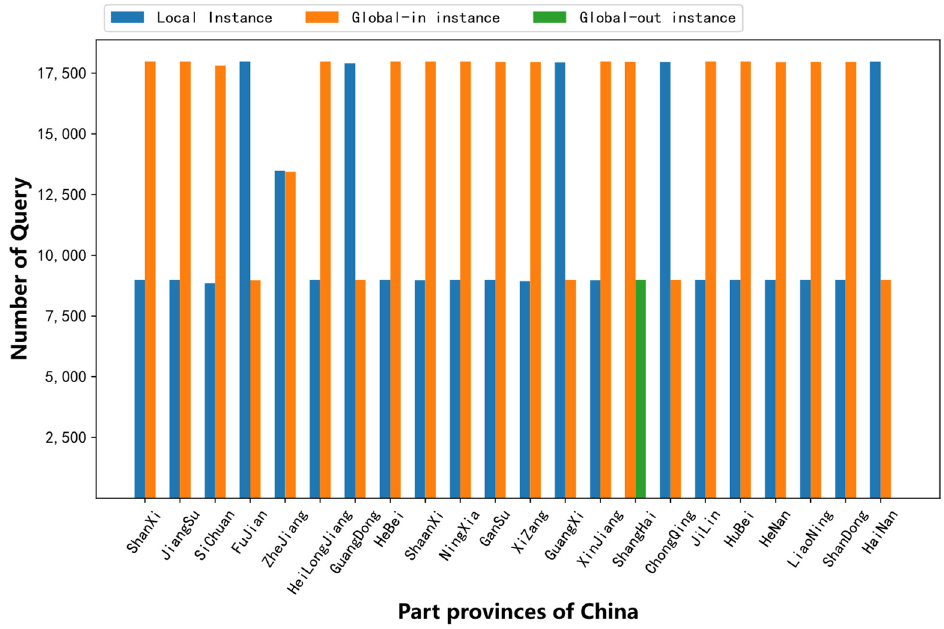
Figure 10. Query quantity to Local, Global-in, and Global-out nodes of K root.